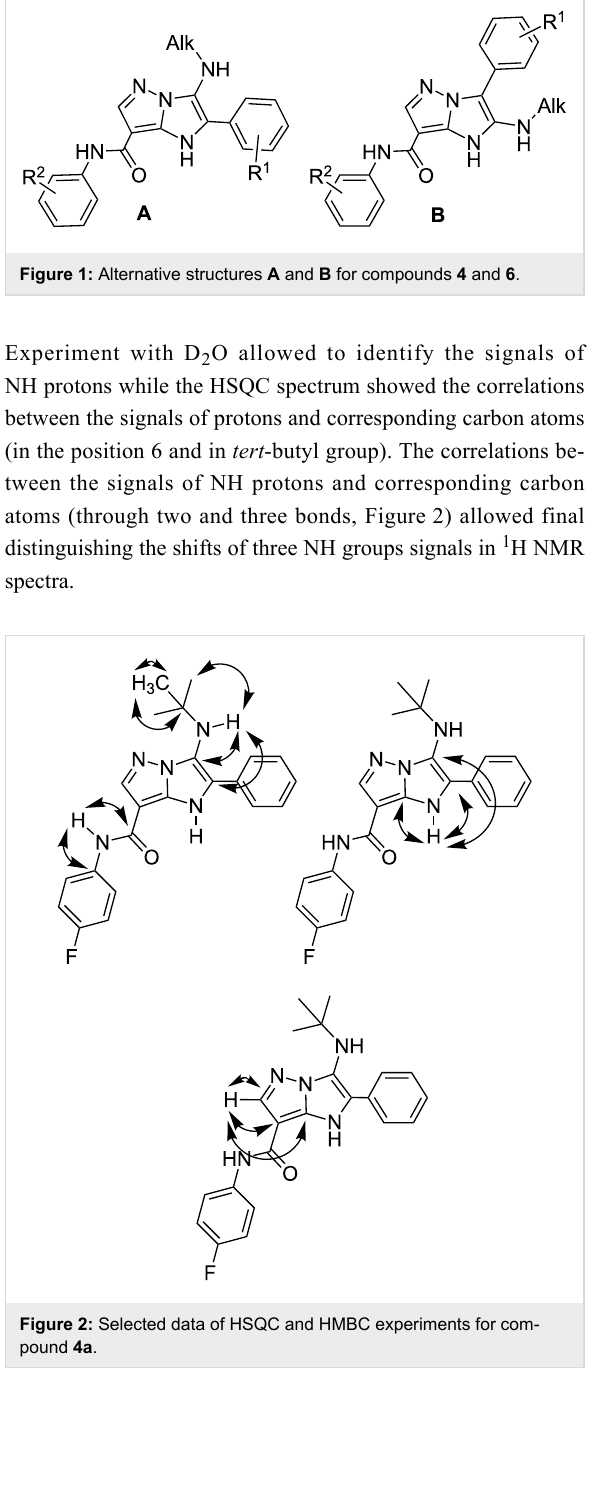
Figure 2: Selected data of HSQC and HMBC experiments for com- pound 4a .